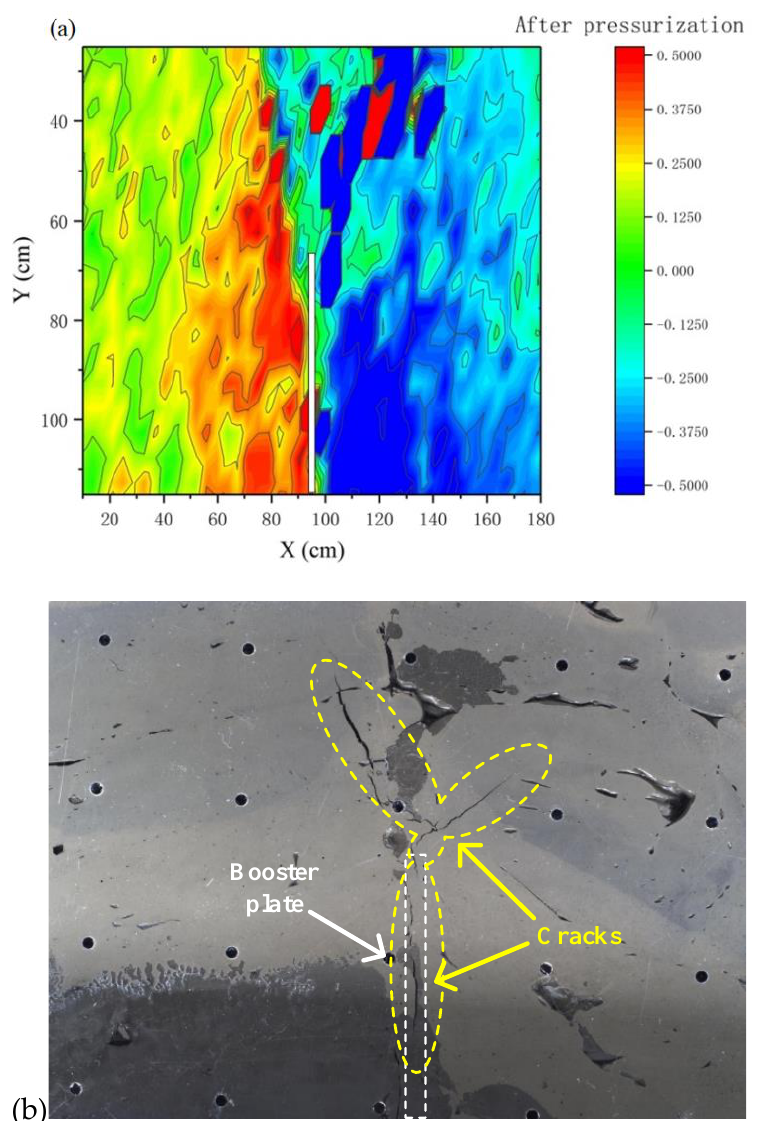
Figure 13. PIV results immediately after air boosting: ( a ) coloured contour on horizontal displacement; ( b ) slurry picture taken on time instant t * = 900 s.